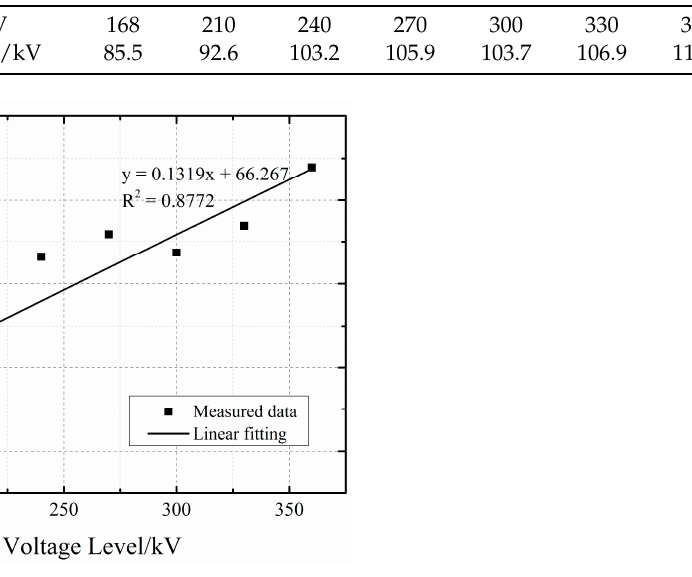
Figure 7. Peak values of residual voltage at different voltage levels.